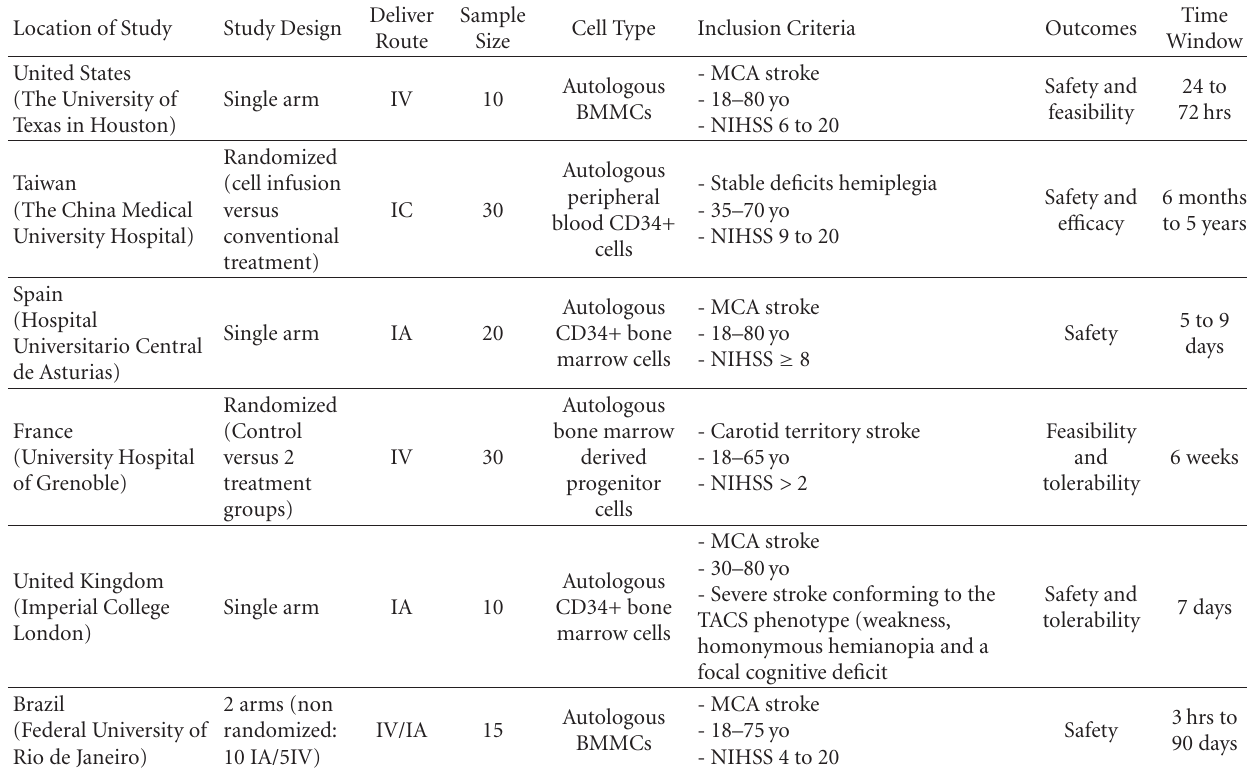
Table 1: Listing of location and details of current clinical trials being completed to investigate the potential role of bone marrow-derived progenitor cell therapeutics for the treatment of ischemic